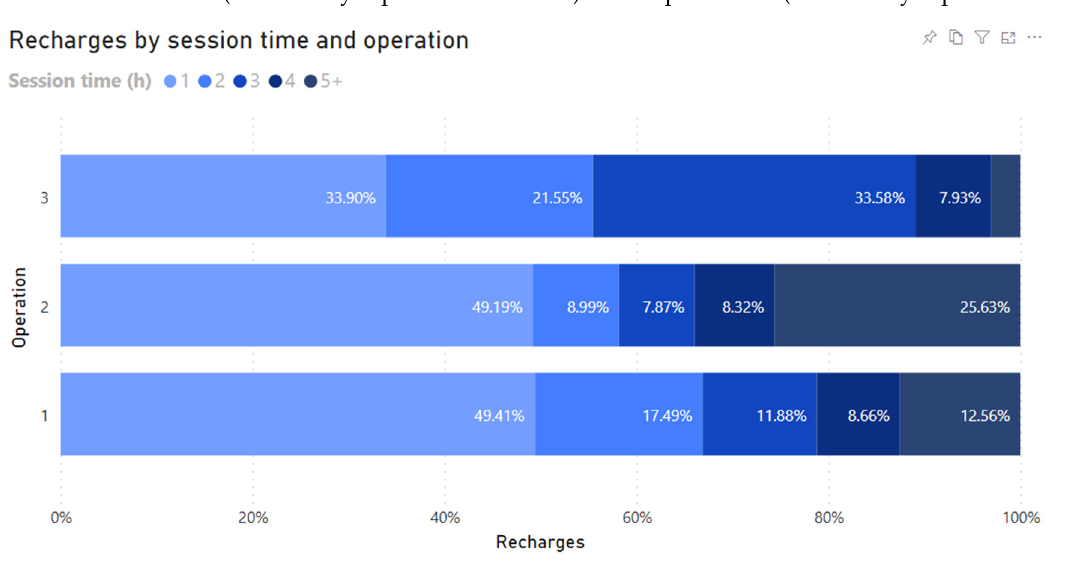
Figure 9. ( a ) Battery capacity by operation; ( b ) charging speed by operation.